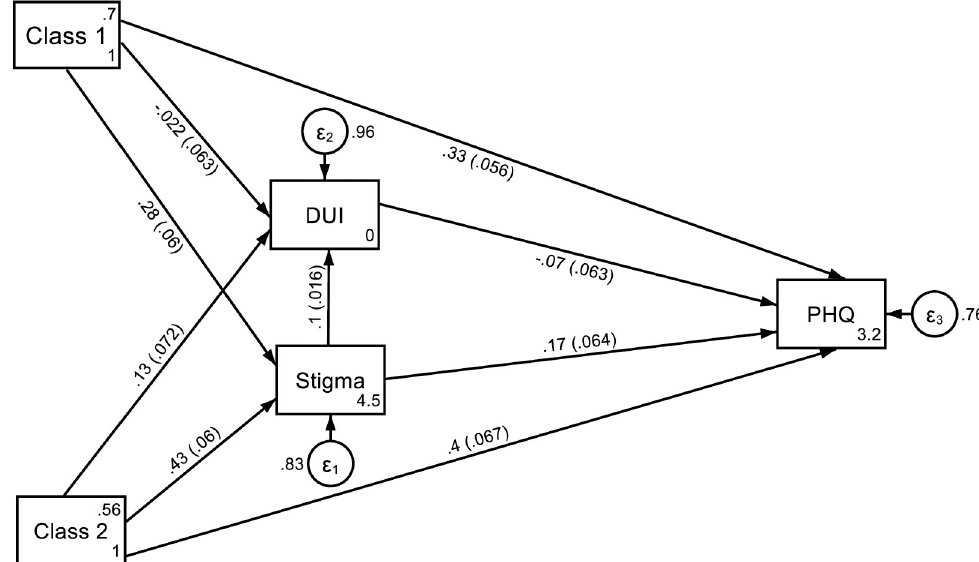
Fig 3. Standardized path coefficients and robust standard errors of the effects of assignment to latent Class1 or latent Class 2 vs. latent Class 3 (reference category) on stigmatizing attitudes (stigma = DSS total sum score), the duration of untreated illness (DUI), and symptoms of mental disorder (PHQ = PHQ-SADS total sum